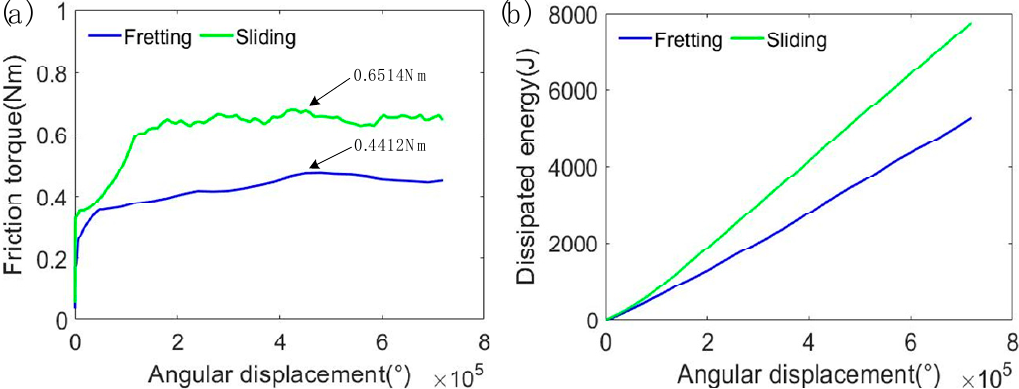
Figure 5. Variations of: ( a ) friction torque; ( b ) accumulated dissipated energy.